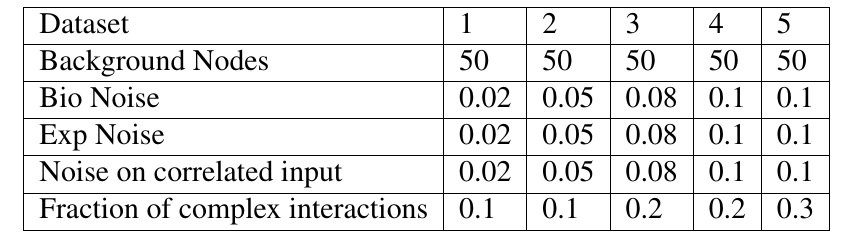
Table 3: Simulated data by SynTReN. Five datasets of n = 100 nodes and 25 timepoints are gener- ated. Parameter settings (set as default except the